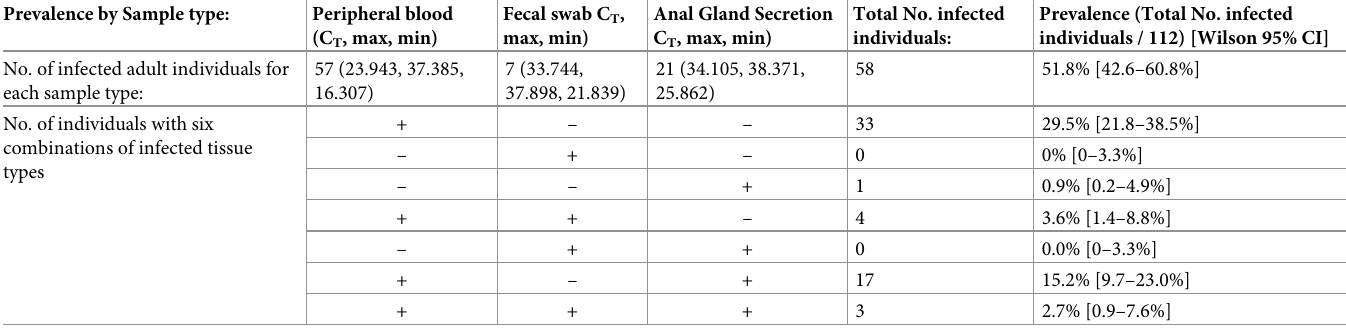
(Table 1). Each county varied in the number of adults sampled, the smallest adult sample size was in Columbia County (n = 13) and the largest was from Alachua County (n = 41) (Table 1). In total, 86 joey opossums were sampled from 25 litters in this study: from 20 litters, 73 joeys were sampled that were dependent on their mother (mother-dependent), and from 5 lit- ters, 13 joeys were sampled that had been weaned from the mother. The largest number of joeys sampled was in Alachua County (n = 41) and no joeys were sampled in Gilchrist or Table 2. Number of individuals infected and prevalence of Trypanosoma cruzi by sample type. Average C T value, maximum and minimum CT value for rtPCR assays are given in parentheses for each tissue type. Prevalence by Sample type: Peripheral blood Anal Gland Secretion Fecal swab C T , Total No. infected (C T , max, min) max, min) C T , max, min)